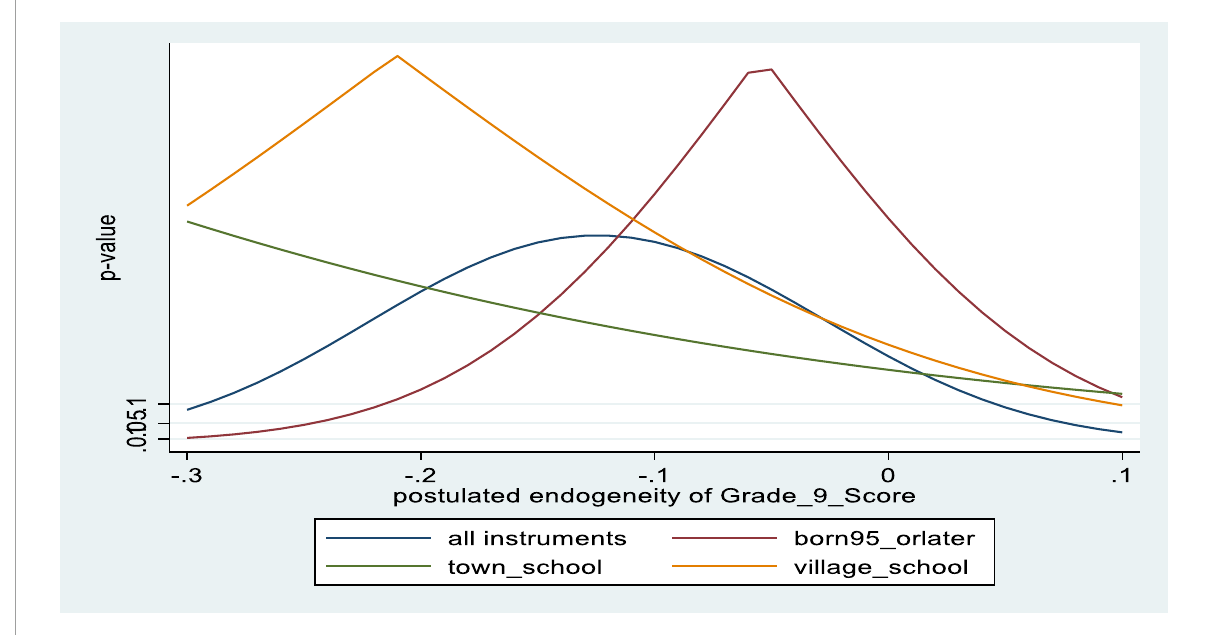
CHART3 Tests of exclusion restrictions of instruments for Grade 9 math score: MALES.